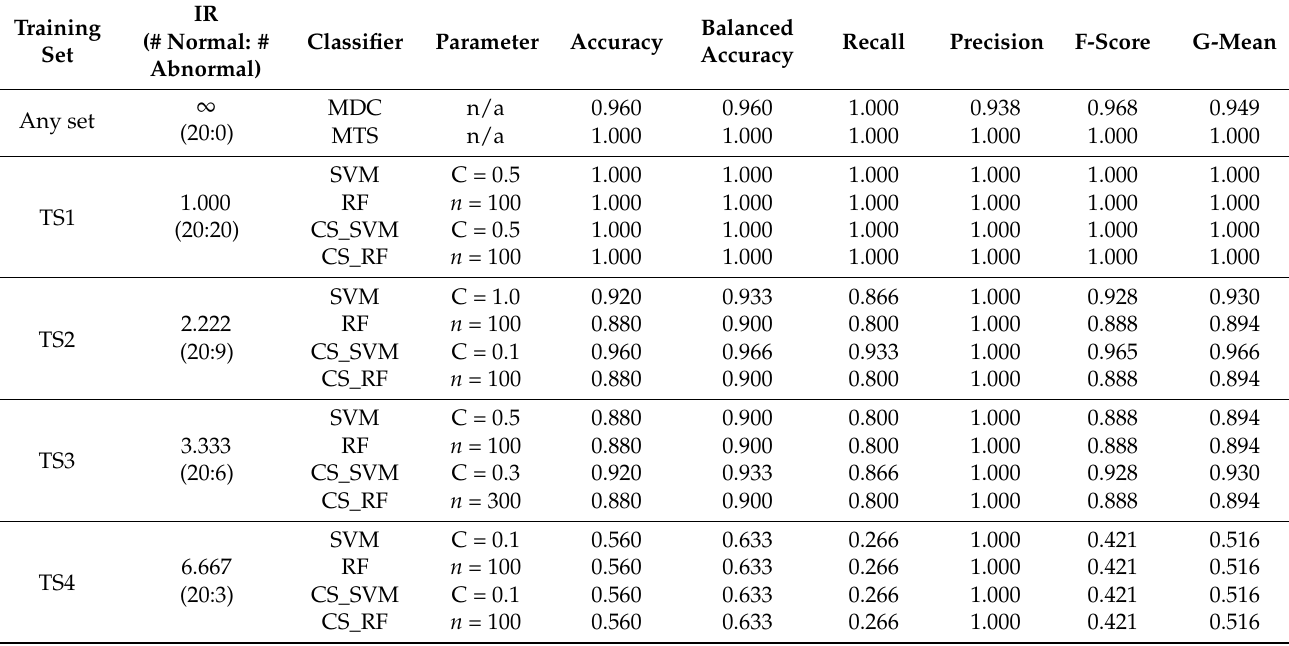
Table 10. Performance for the test set of classifiers trained with different training